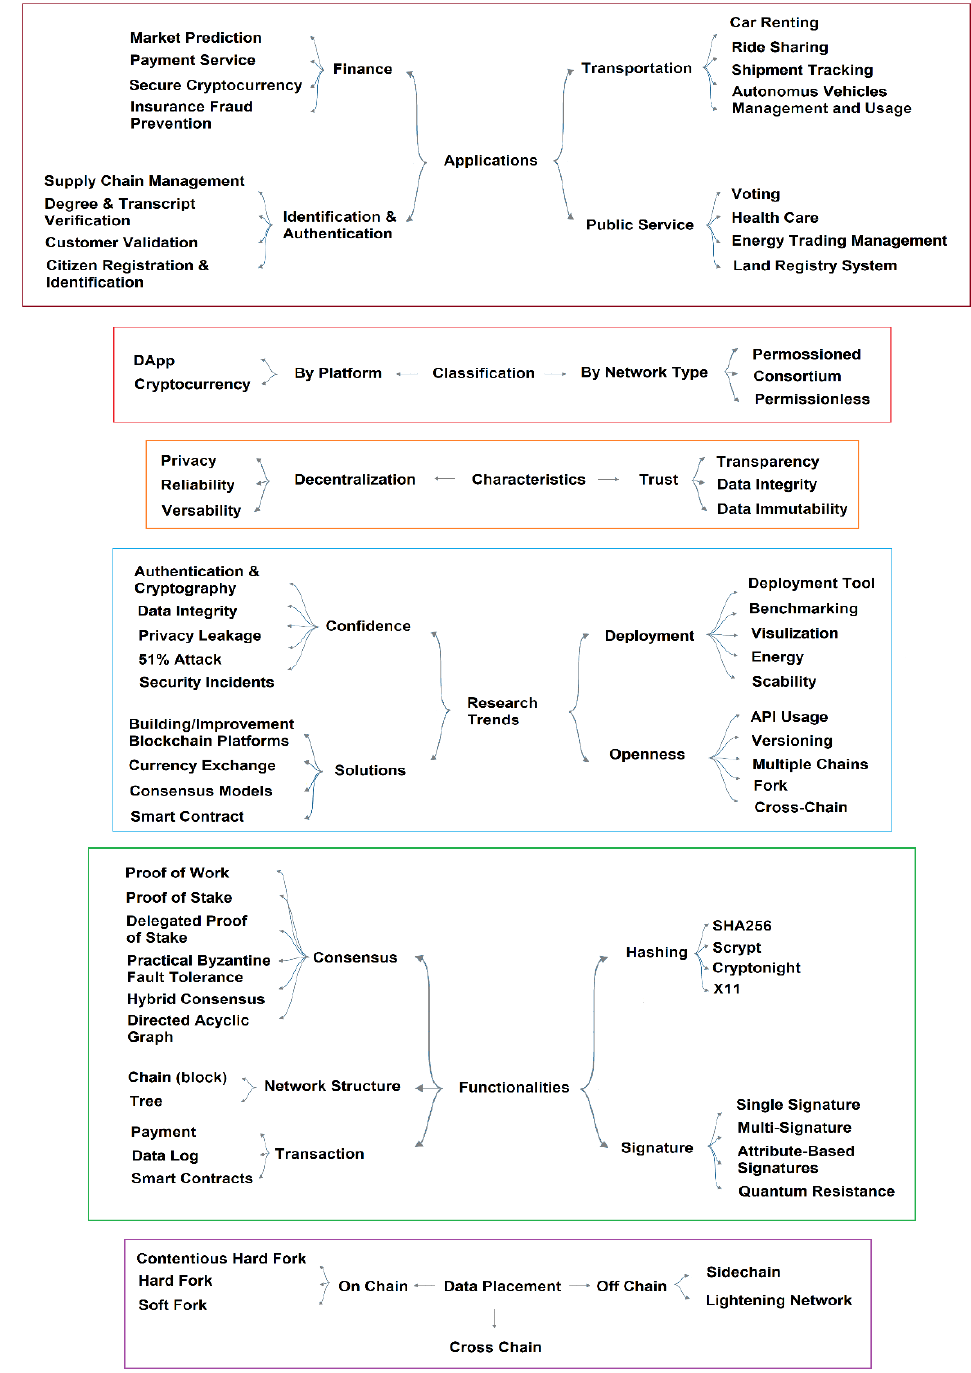
Figure 1. Blockchain